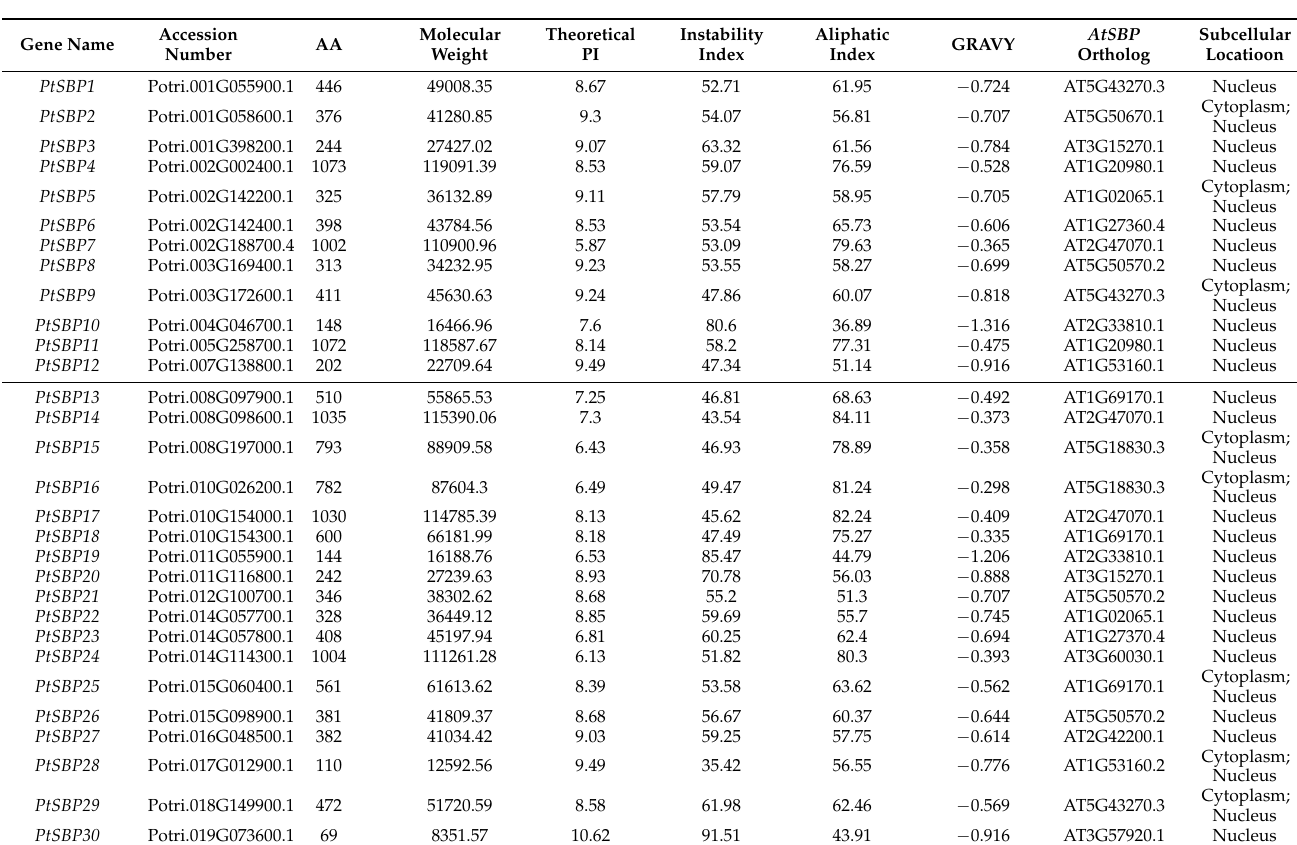
Table 1. Analysis of PtSBP